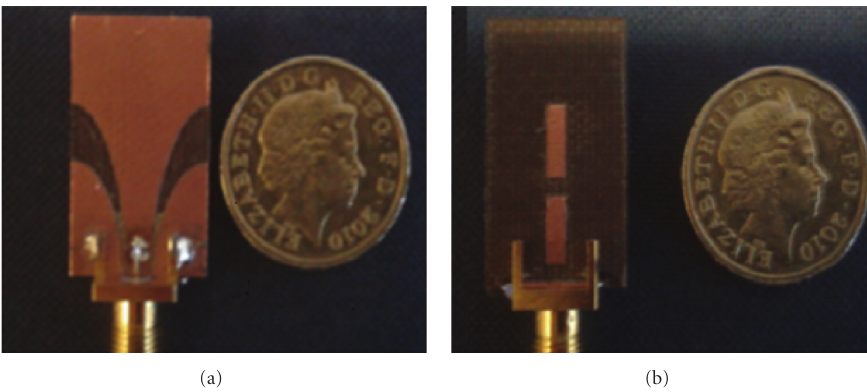
Figure 2: Antenna prototype: (a) top view, (b) bottom view.